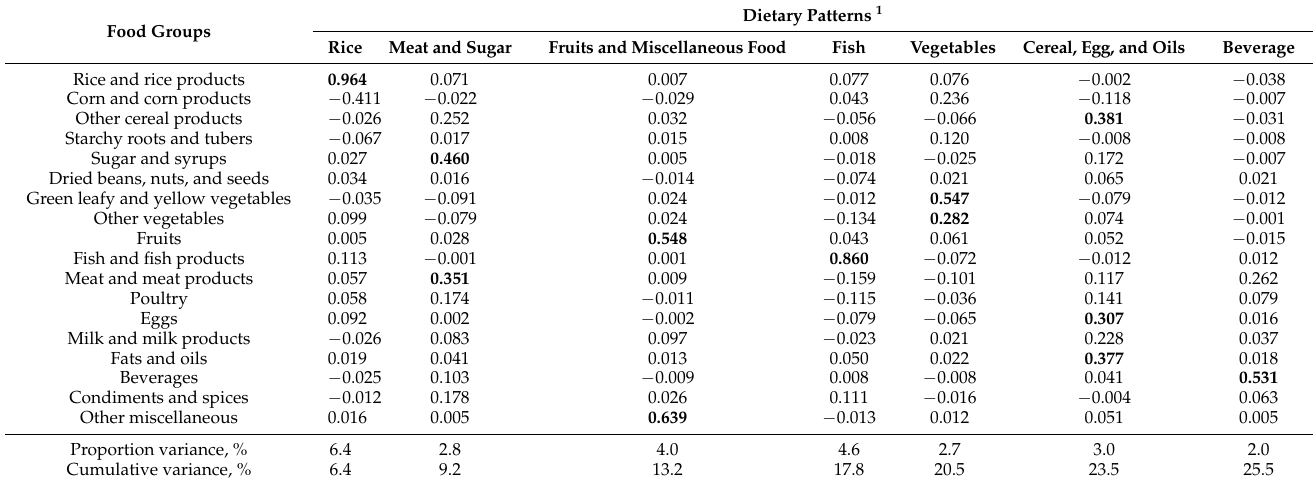
Table 3. Factor loadings for the seven dietary patterns identified among males.